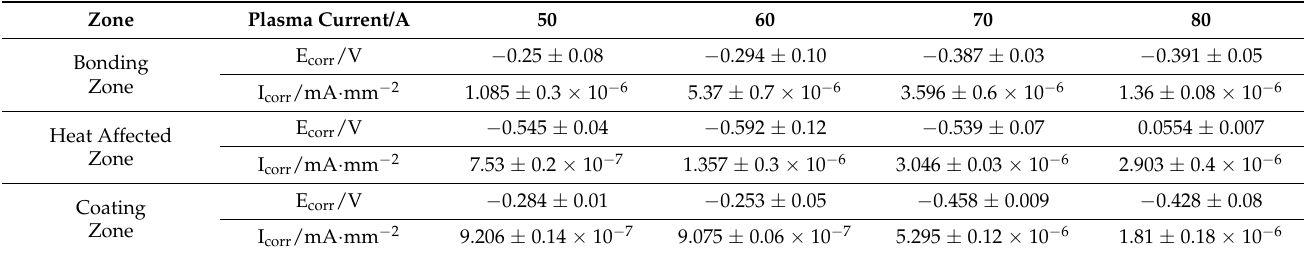
Figure 9. Polarization curves of substrate and HEA coatings in different zones: ( a ) bonding zone, ( b ) Heat affected zone and ( c ) coating zone. Table 7. Self-corrosion potential and current density of the HEA coatings.